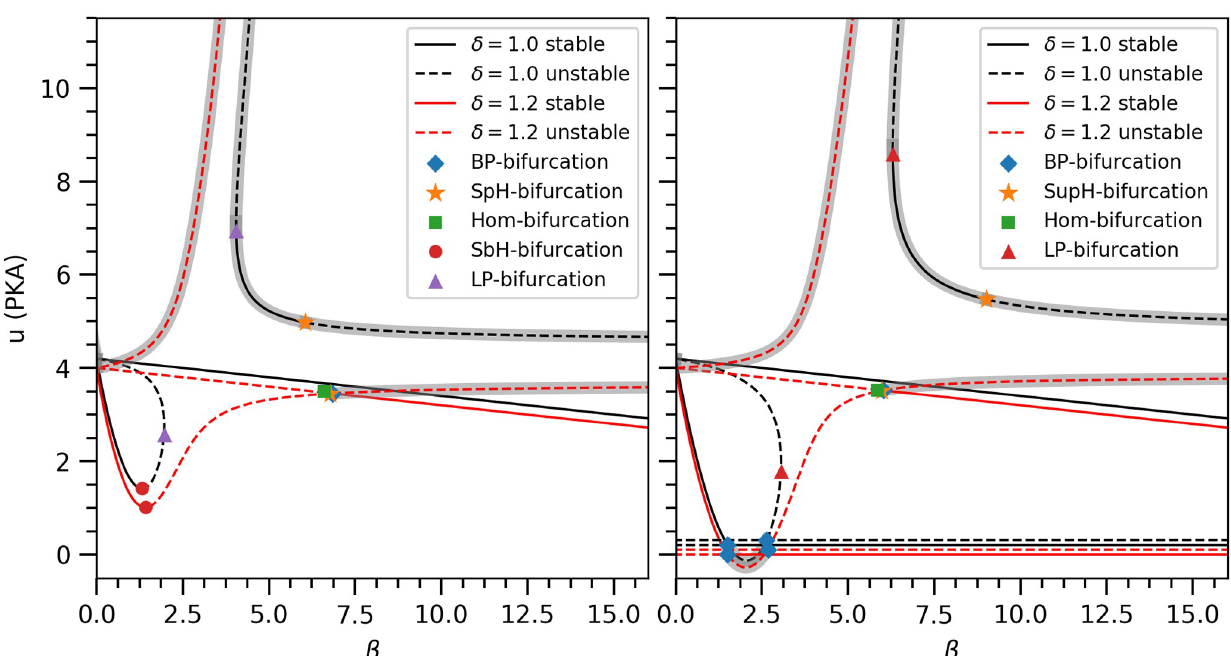
Fig 5. Stability of fixed points and their bifurcations for different values of β , γ and δ . Abbreviations for various bifurcations as BP: Branch point, SpH: Supercritical Hopf, SbH: Subcritical Hopf, Hom: Homoclinic, LP: Limit point. Each curve corresponds to one fixed point solution for given set of parameters values. Solid lines represent stable fixed points, while dashed lines represent unstable or saddle fixed points. The black curves in both panels are shifted upwards to differenciate them from the red curves as they would overlap otherwise. We ignored the fixed point (0,0,0) as it remains unstable for all γ > 0, δ > 0 and β < u 0 / α > > 1. Unphysical solutions are shaded with a gray background. Left panel ( γ = 1.4 μM − 1 ): For δ = 1.0, the relevant fixed point is stable for all shown values of β values. For δ = 1.2, the same fixed point is only stable for larger values of β . When decreasing β , it becomes a saddle point through a branch point. Over a very limited range in β the new stable fixed point first loses its stability through a supercritical Hopf bifurcation giving rise to a stable limit cycle, which then is destroyed through a homoclinic bifurcation around β = 6.7645, turning the original relevant fixed point into the attractor of the physically relevant dynamics despite being a saddle point. This continues to be the case until a new stable fixed point emerges through a sub-critical Hopf bifurcation at much lower values of β . Right panel ( γ = 0.9 μM − 1 ): In addition to the fixed points in the left panel, a new pair of fixed points with u = 0 is present for this smaller value of γ since the quadratic v -nullcline is shifted down. For clarity, we have shown them as separate lines (two for each value of δ ). One of them is stable over a large range of β . The pair of new fixed points undergoes their own bifurcations at β = 1.5076 and β = 2.6795, respectively, replacing the sub-critical Hopf